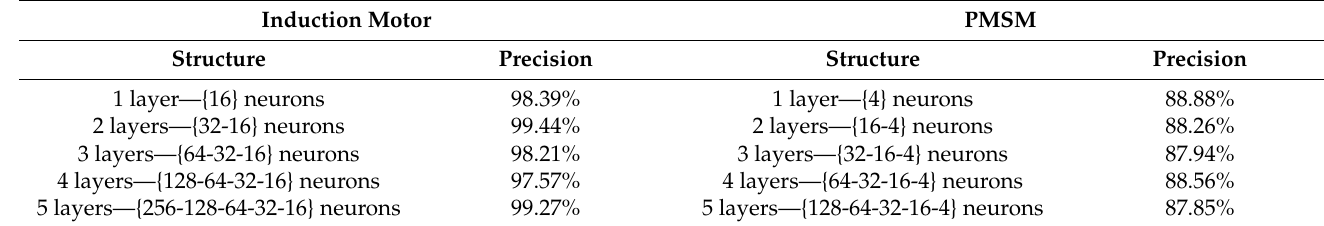
Table 3. Effect of the number of fully connected layers on CNN precision.